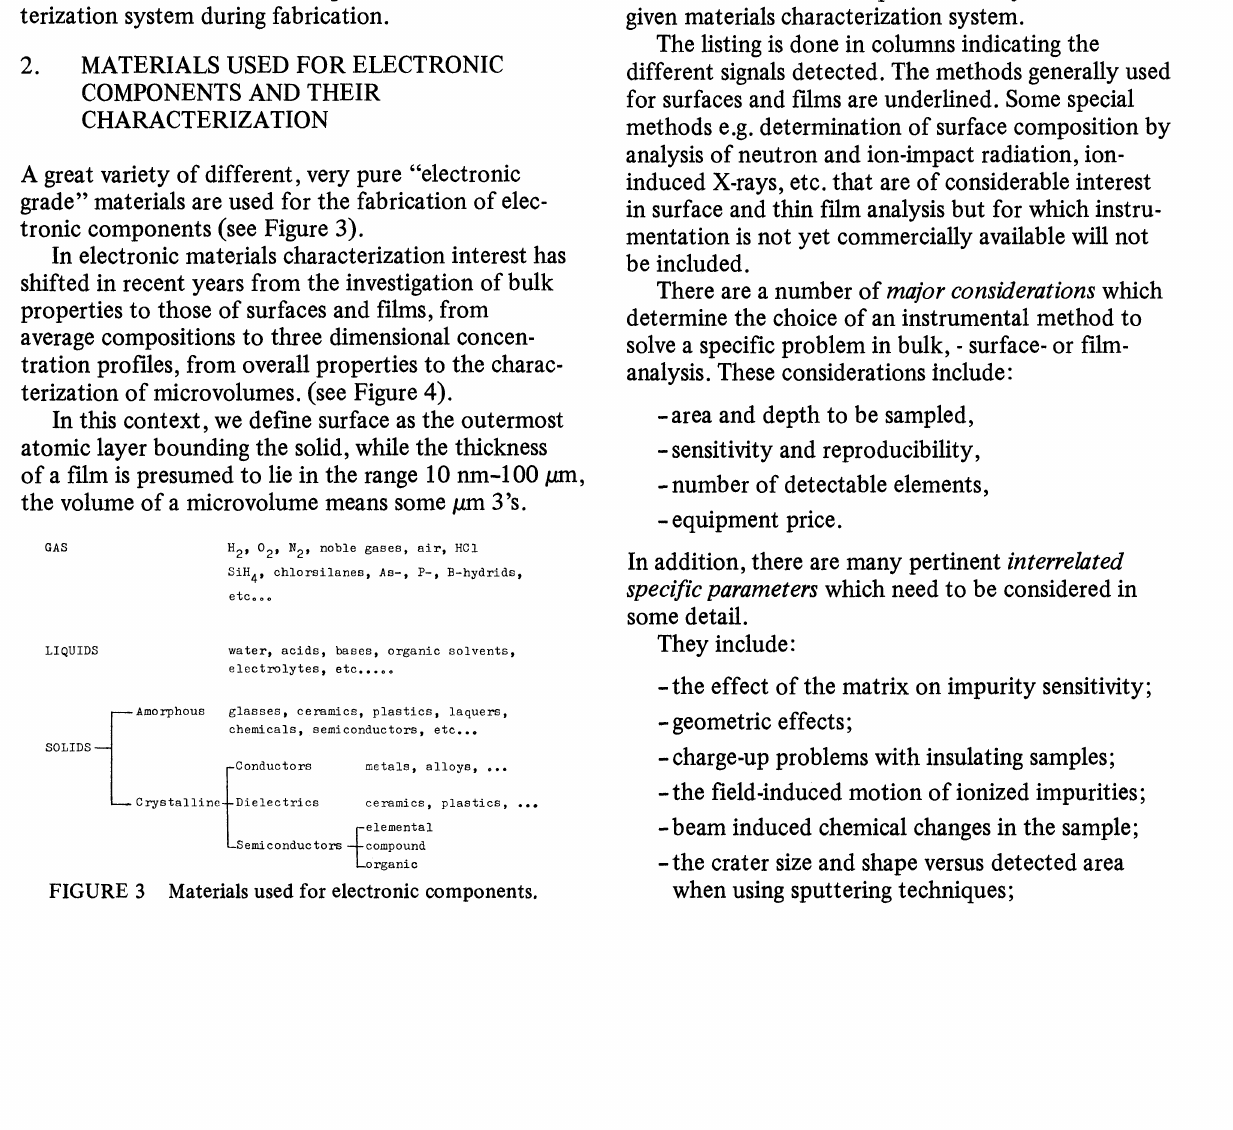
FIGURE 2 Important activities in materials characterization.